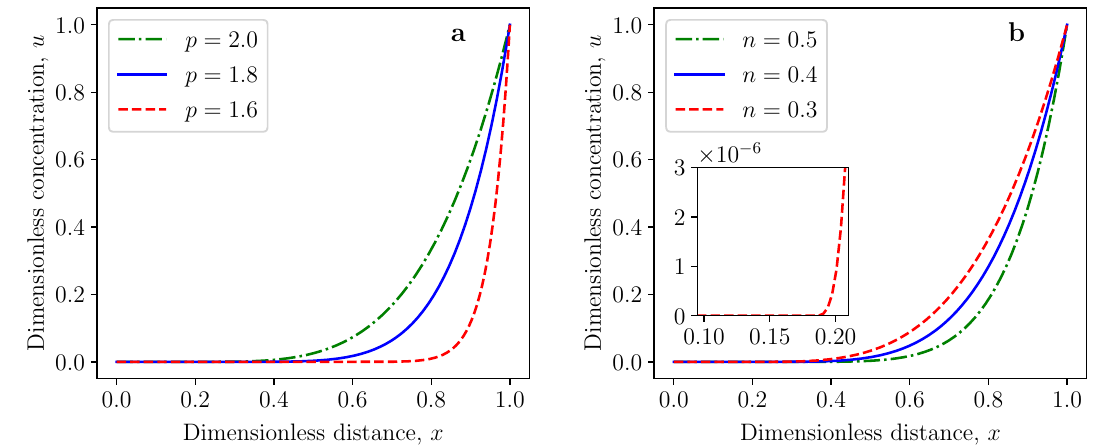
1.2 φ ∗ p , n and for ( a ) various diffusion exponents and fixed =